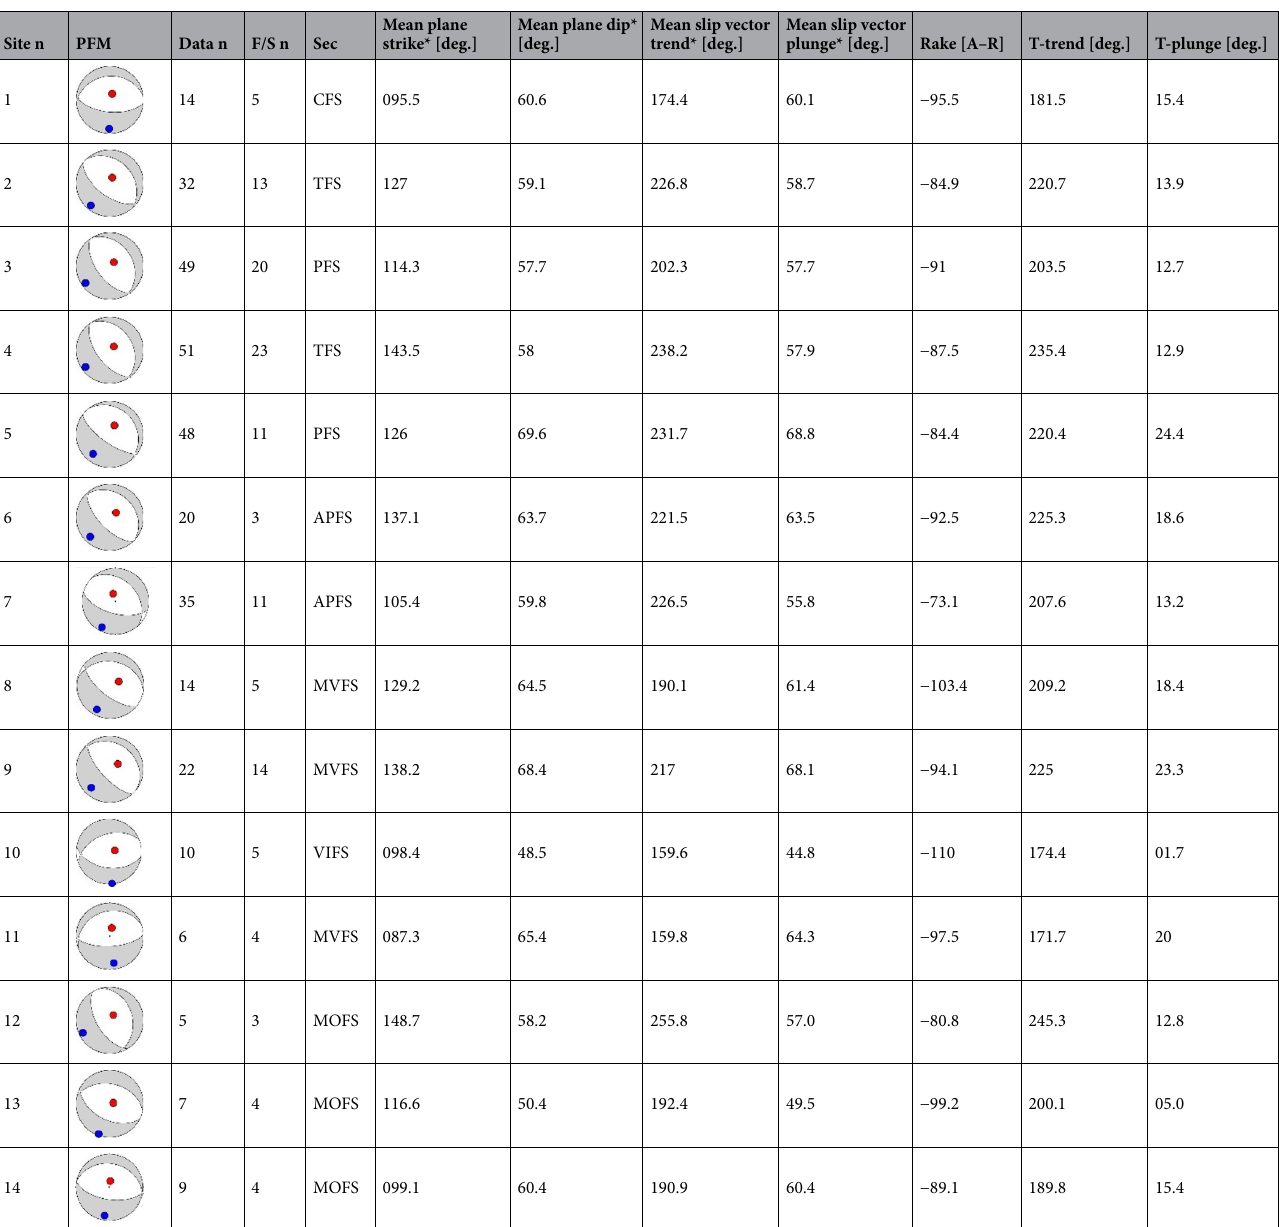
Table 1. Pseudo focal mechanisms. Site numbers correspond to the data group in Fig. 3. PFS = pseudo focal mechanisms computed from structural data. Data N = number of fault planes and slip vector measurements. F/S n = number of measurements used in the pseudo focal mechanism calculation (fault/striation pairs). Sec. = CMF sections (CFS: Caggiano fault section; TFS: Timpe fault section; PFS: Polla fault section; APFS: Atena-Paterno fault section; MVFS: Marsicovetere fault section; VIFS: Viggiano fault section; MOFS: Montemurro fault section). Seg. dip dir. = segment’s dip direction. Rake is in Aki-Richards’s format. T axes (trend/plunge) were computed with the dihedron angle method 73 . *Average attitude calculated from the main synthetic